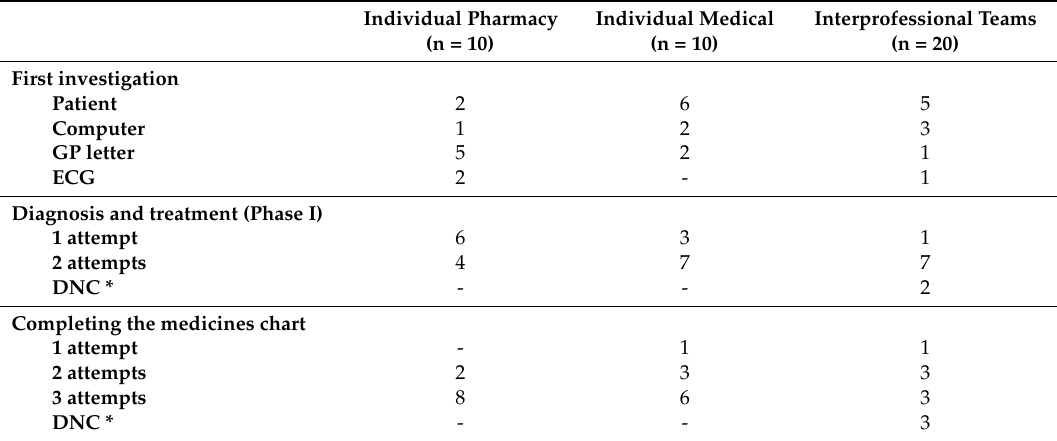
Table 2. Summary table of observations during the simulation